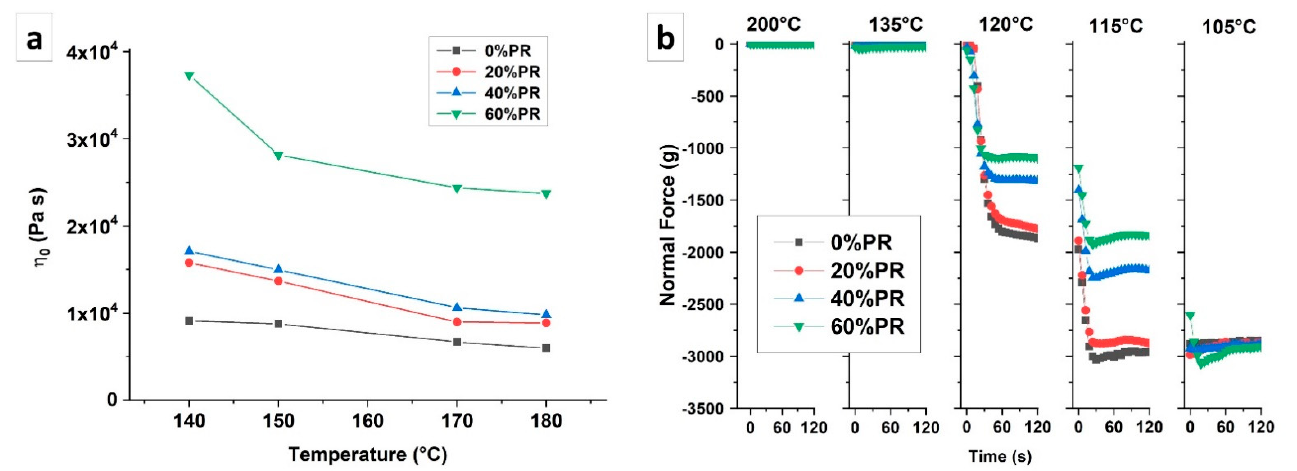
Figure 5. ( a ) Newtonian viscosity as a function of the rheological test temperature. ( b ) Normal force at a constant gap measured at different temperatures.